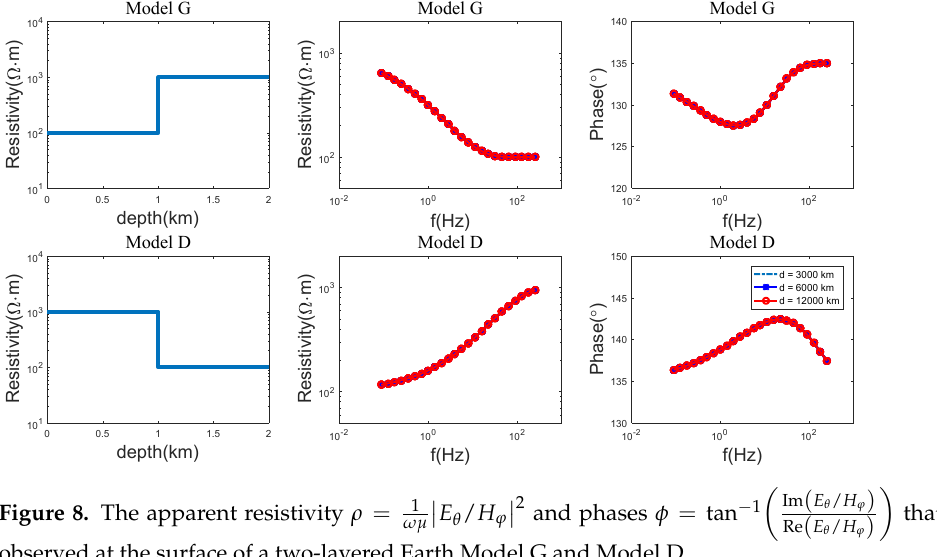
Figure 8. The apparent resistivity ρ = 1 Figure 8. The apparent resistivity and phases observed at the surface of a two-layered Earth Model G and Model D. served at the surface of a two-layered Earth Model G and Model D. 100 km, the current is 100A, the transmission frequency is 2 n Hz, n = − 3.5:0.5:8, and the interval is 0.5. The height of the ionosphere is h = 70 km, and the resistivity of the ionosphere, air, and Earth layers are ρ i = 10 5 Ω · m, ρ 1 = 10 14 Ω · m, ρ 2 = 10 2 Ω · m, and ρ 3 = 10 3 Ω · m, respectively. The thickness of the upper layer is taken to be l = 1000 m. The observation azimuth is ϕ = π /4, and the distances from the source center are 3000 km, 6000 km, and 12,000 km, respectively. Additionally, the observation point and the transmitting antenna are both located on the ground